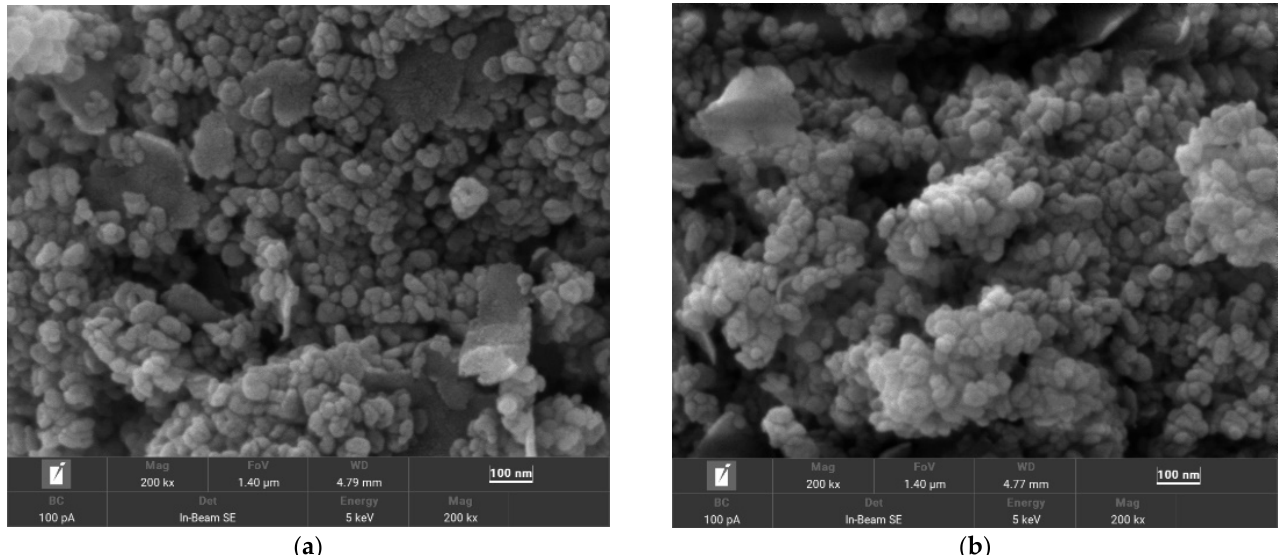
Figure 8. SEM Diagram of Precipitated Products at Different Temperatures: ( a ) 60 °C and ( b ) 120 °C.